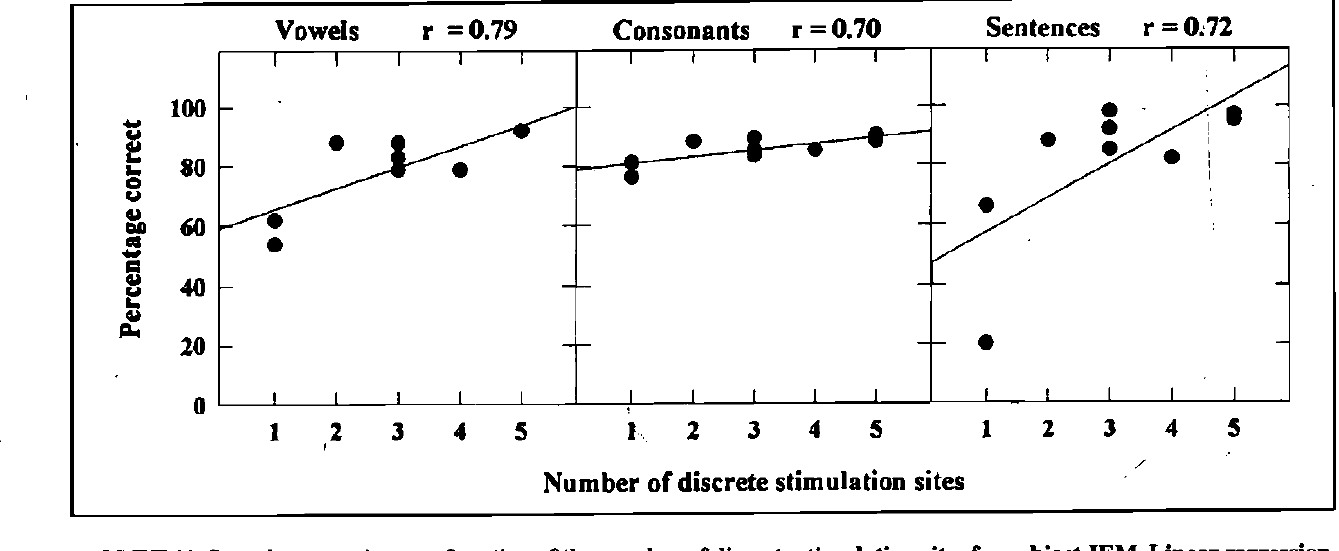
FIGURE 11. Speech perception as a function of the number of discrete stimulation sites for subject JEM. Linear regression lines are fitted through the data and correlation coefficients are given above each panel. The number of discrete sites were calculated for each map by taking a d' value of larger than 1.5 as criterion for two electrodes stimulating discrete neural